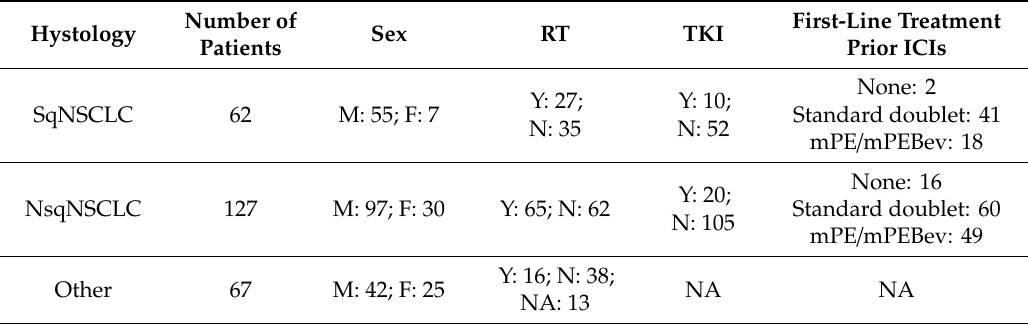
Table 1. Clinical characteristics of patients.